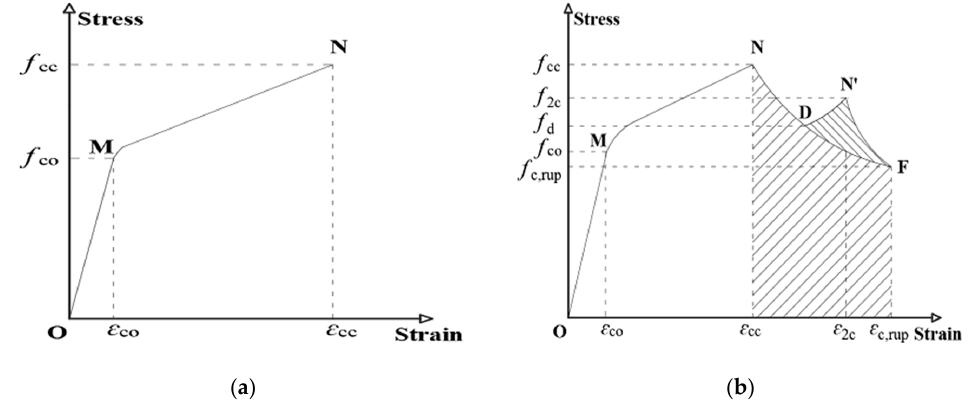
Figure 5. General stress–strain behavior of: ( a ) Hybrid DSTC; ( b ) BFST-DSTC.